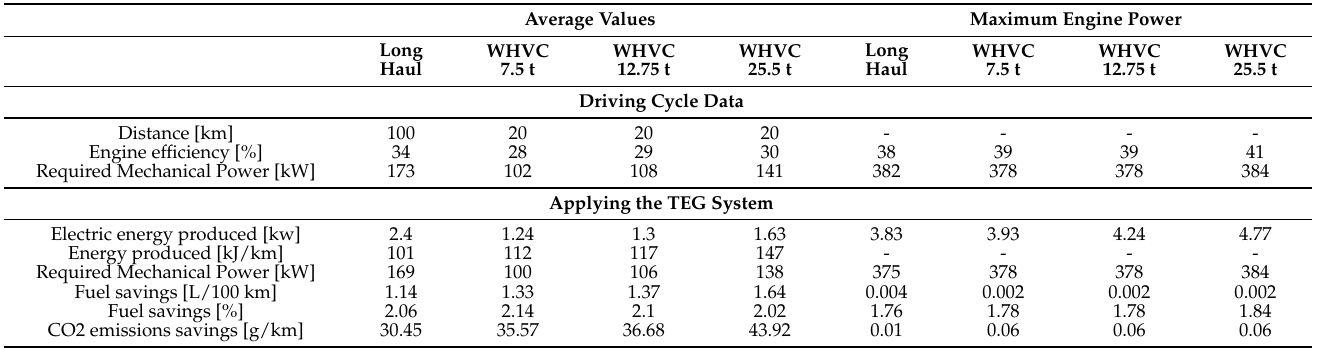
Table 3. Average maximum engine power savings from applying the developed TEG system within the several cycle